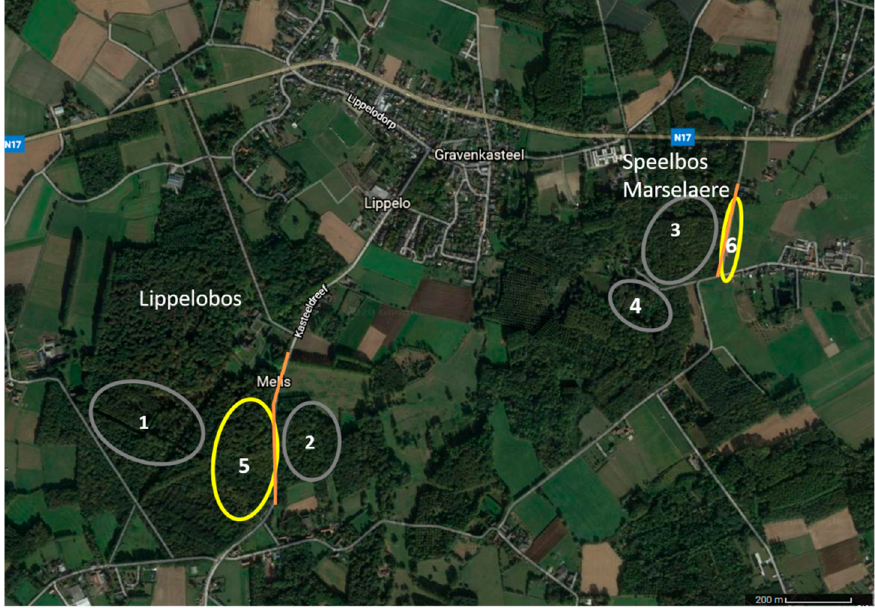
Figure 1. Map of the locations used. The dark locations are indicated in grey (nr 1–4) and the illuminated locations in yellow (nr 5 and 6). The orange lines represent the lit streets .